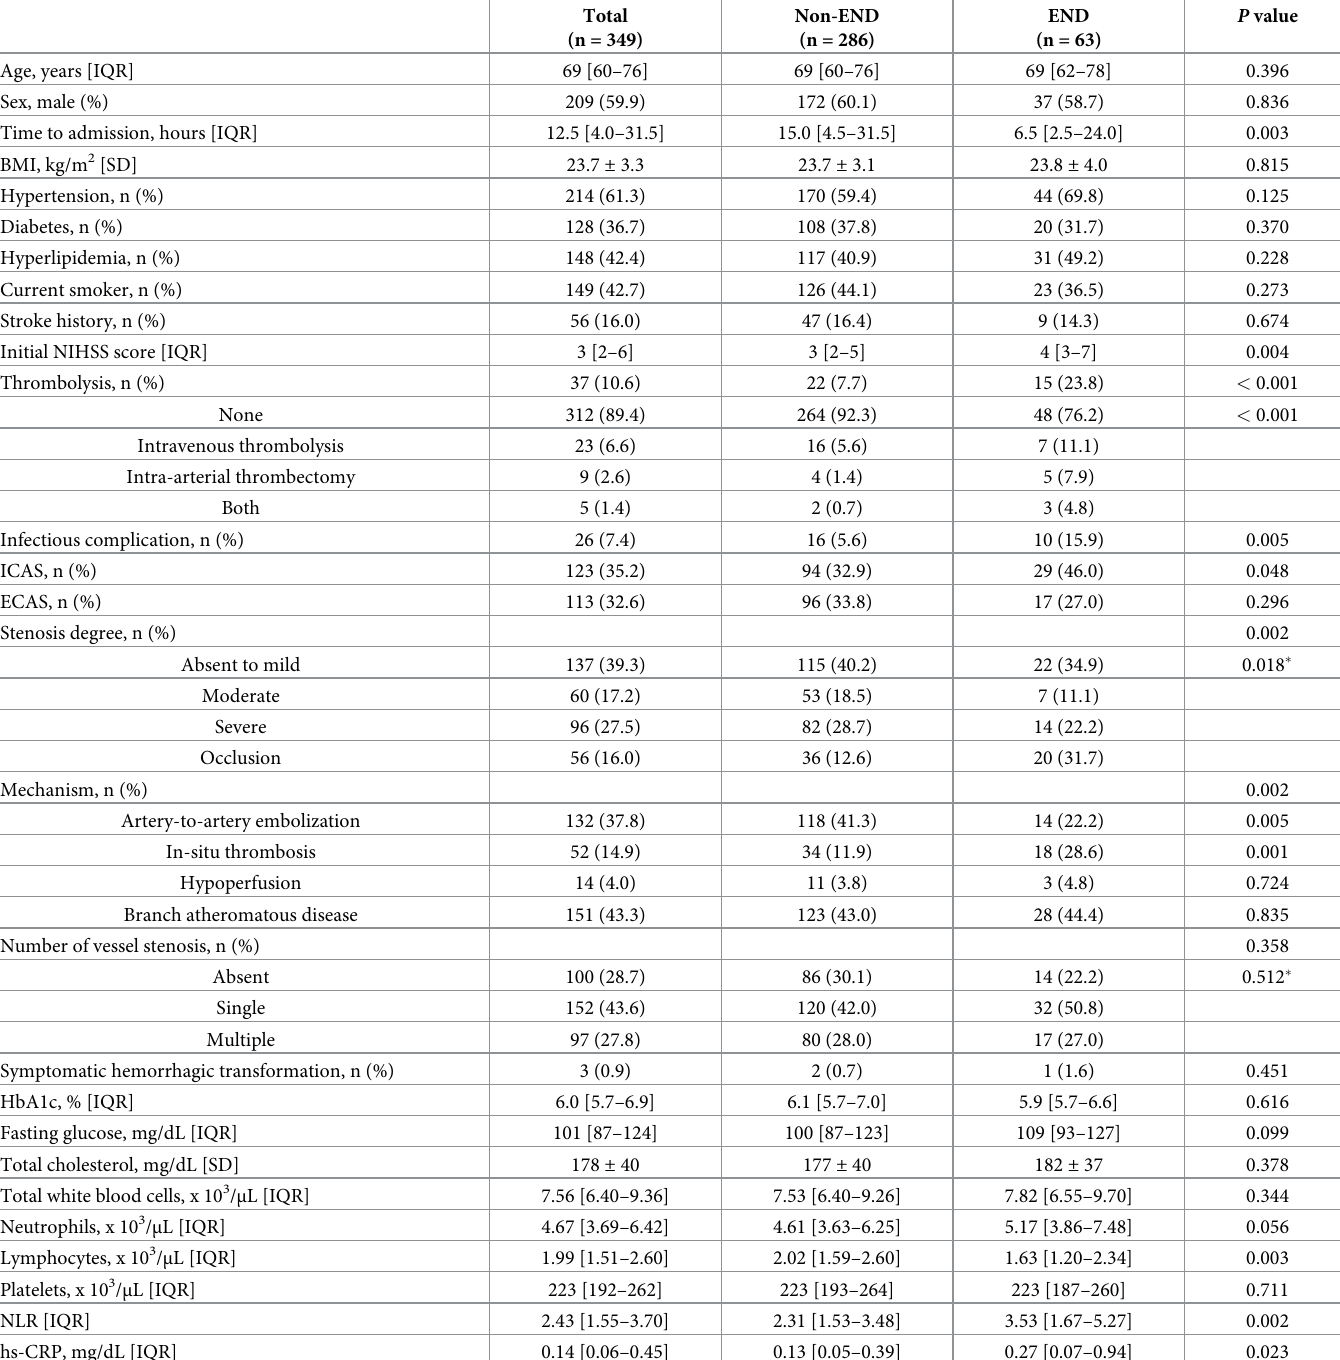
Table 1. Baseline characteristics in END and non-END patients with acute ischemic